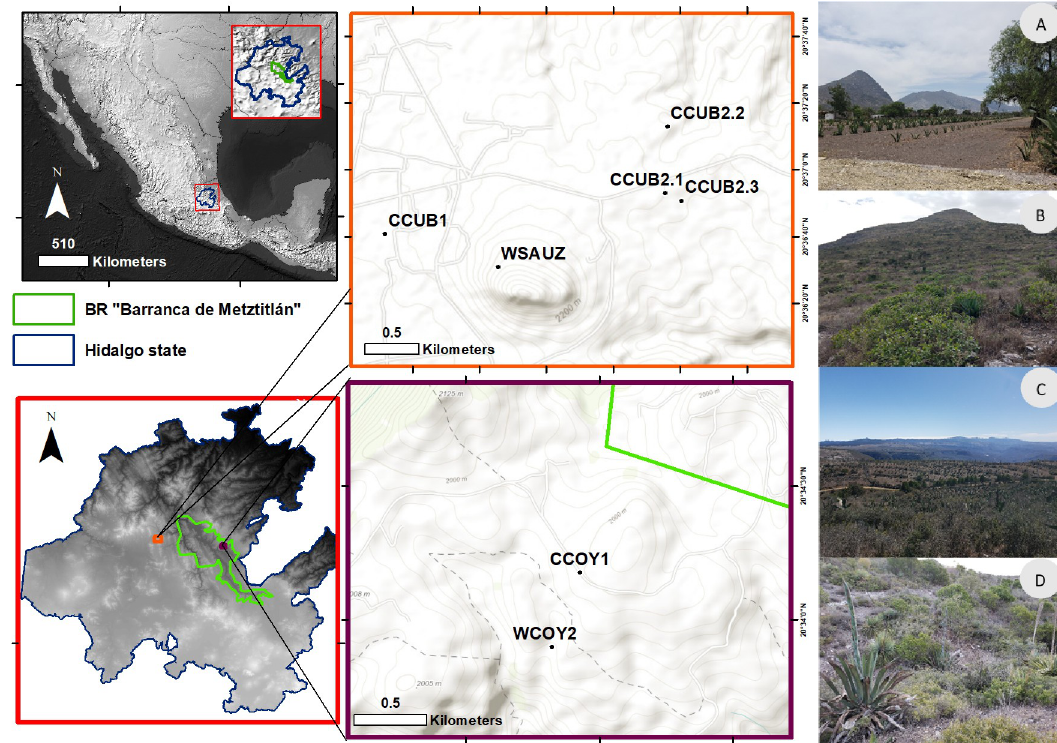
Fig 1. Localities studied in the state of Hidalgo (data set https://www.naturalearthdata.com/ and https://www.inegi.org.mx/ app/geo2/ntm/). A) View of agave crops (Traditional varieties Poblano , Agave salmiana var. salmiana ) as living fences and in rows interspersed with other crops (CCUB), B) Cerro Blanco or El Fraile, where agaves were measured (Traditional varieties Corriente , A . salmiana ssp. crassispina , WSAUZ), C) Panoramic view of the crops in Jilas in La Coyotera (mainly Manso de zoqui , A . salmiana var. salmiana CCOY1), D) Xeric scrubland at La Coyotera in the Barranca de Metztitla´n Biosphere Reserve, where individuals of Agave salmiana ssp. crassispina can be seen